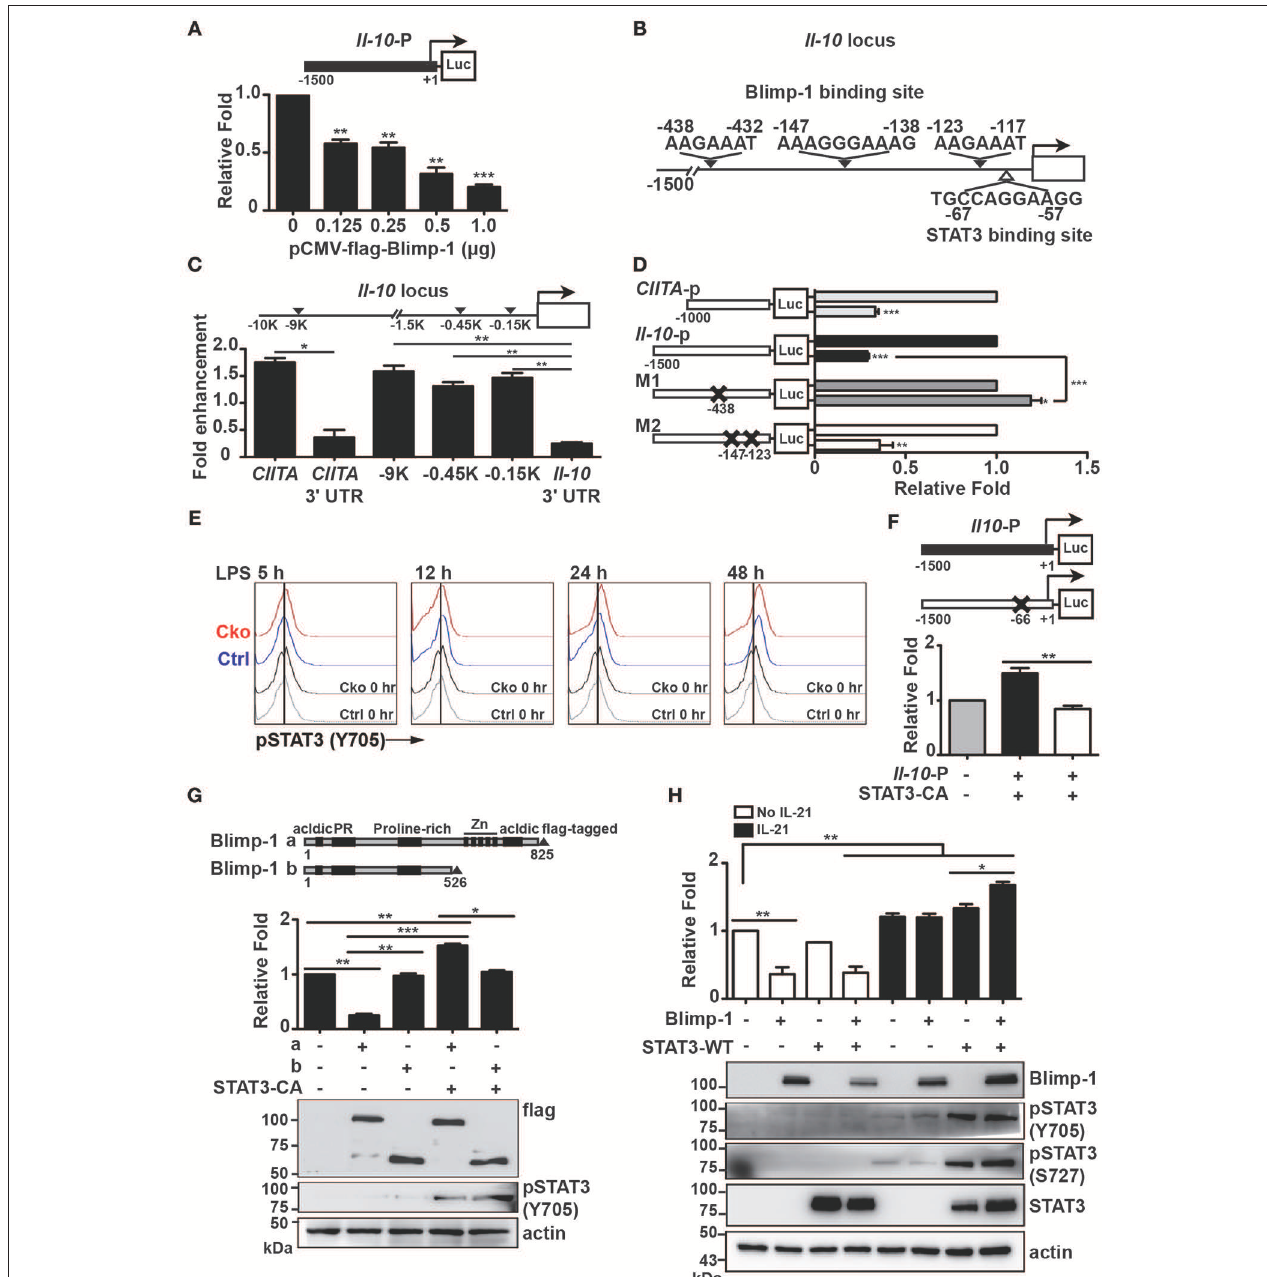
FIGURE 7 | Blimp-1 collaborated with STAT3 to upregulate Il-10 expression. (A) Relative fold differences of the Il-10 promoter-dependent luciferase reporter activities repressed by the indicated doses of Blimp-1 expression plasmid in Raji B cells at 48h post-transfection. (B) Schematic representation of predicted Blimp-1- and STAT3-binding sites on the Il-10 promoter. (C) ChIP analysis of Blimp-1 binding to the Il-10 promoter in LPS-stimulated splenic B cells. The binding of Blimp-1 to − 9kb of TSS and CIITA promoter III was used as the positive control, while the CIITA 3’UTR and Il-10 3’UTR served as negative controls. (D) Il-10 promoter-dependent luciferase reporters carrying mutations in − 438–432 bp of TSS (M1) or in − 147 to − 138 bp and − 123 to − 117 bp of TSS (M2) were used in co-transfection in luciferase reporter assays. The CIITA promoter III was used as the positive control. (E) STAT3 was phosphorylated at tyrosine 705 in splenic B10 cells purified from Ctrl or Cko mice and stimulated with LPS at the indicated timepoints. (F) Raji B cells were co-transfected with wildtype or STAT3-binding-site-mutated Il-10 promoter-dependent luciferase constructs along with an expression plasmid encoding a constitutively active form of STAT3 (STAT3-CA). (G) Plasmids encoding STAT3-CA and full-length (a) or a truncated form of Blimp-1 lacking the DNA binding domain (b) were used in the Il-10 promoter-dependent luciferase reporter assay. The expression of Blimp-1 and phosphorylated STAT3 (Y705) was confirmed by immunoblotting. (H) Luciferase reporter assays were conducted in Raji B cells co-transfected with the Il-10 promoter-dependent luciferase reporter and the indicated plasmids in the presence or absence of IL-21 (20 µ g/ml) treatment for 48h. The expression of Blimp-1 and pSTAT3 (Y705 and S727) was confirmed by immunoblotting. Results are from three independent experiments and were analyzed by using an unpaired Student’s t -test. Data are the mean ± SEM. * p < 0.05, ** p < 0.01, and *** p < 0.001.